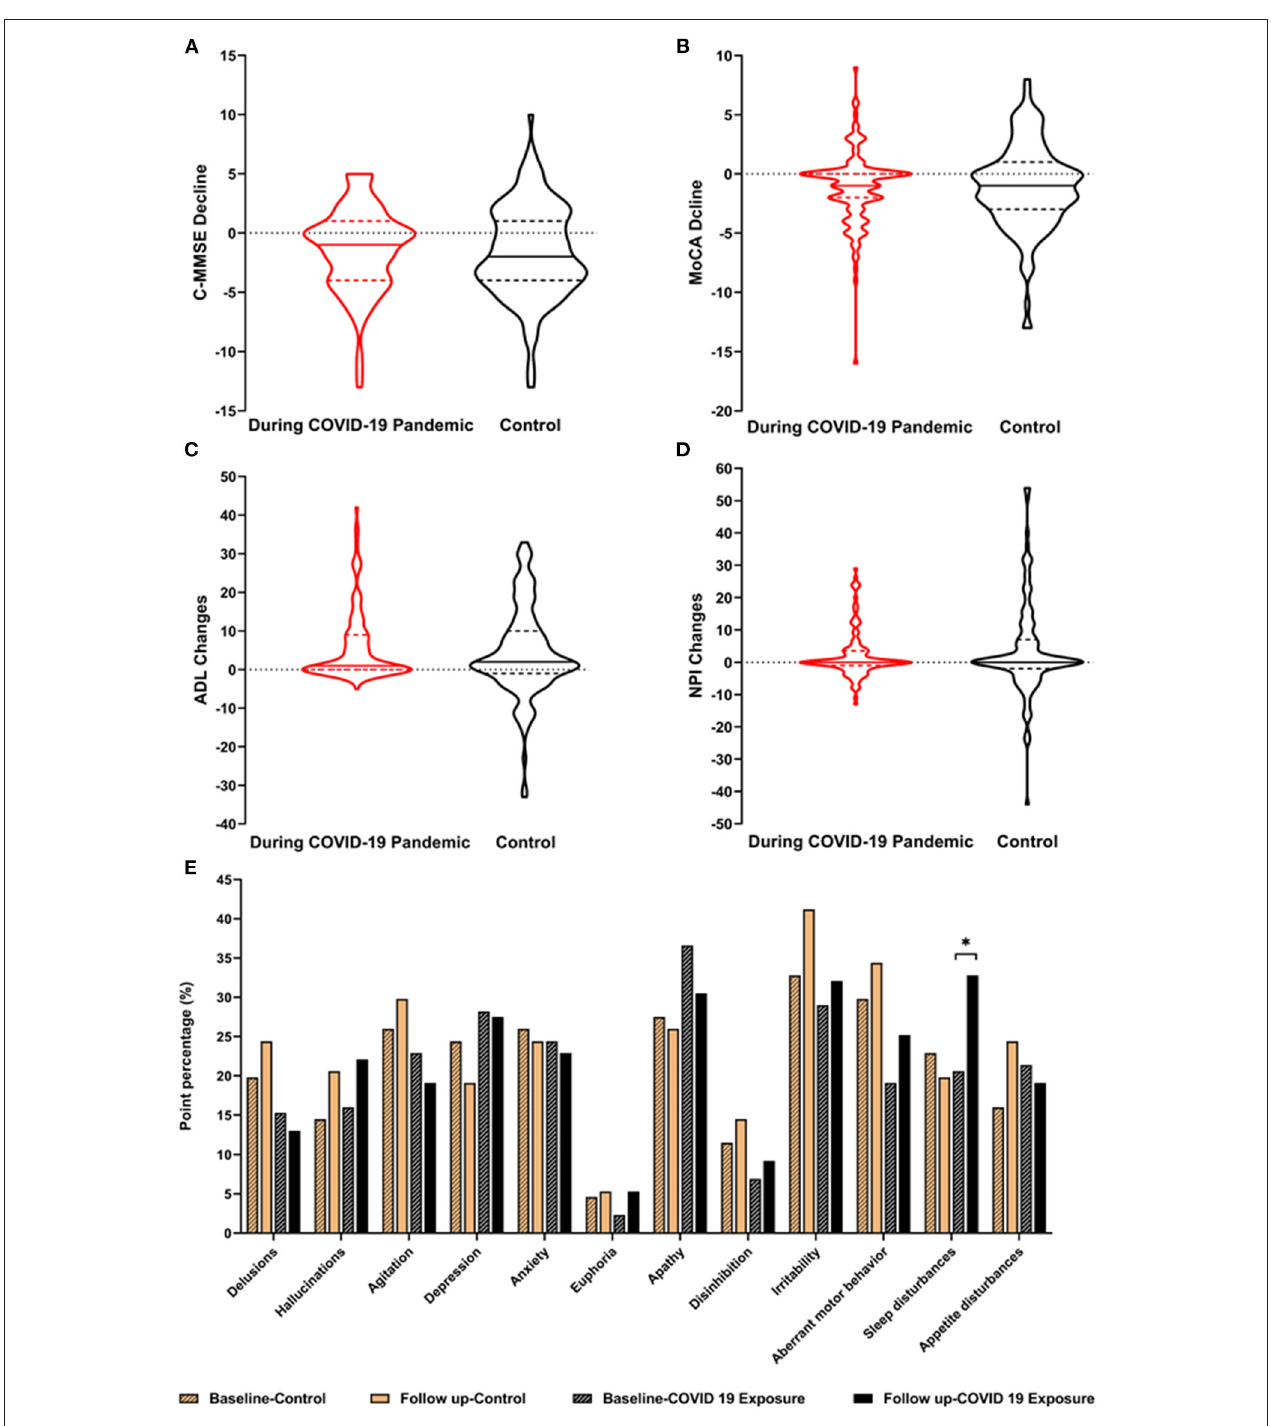
FIGURE 2 | Cognitive and neuropsychiatric changes between the AD groups. The changes in the cognitive and neuropsychiatric scores before and after the COVID-19 pandemic are described in A–E . The point percentages of the 12 NPI items are described to show the comparison before (control group) and after COVID-19 (COVID-19 exposure group) at baseline and at the 1-year follow up. AD, Alzheimer’s disease; C-MMSE, Chinese Mini-Mental State Examination; MoCA, the Montreal Cognitive Assessment; ADL, activities of daily living; NPI, the Neuropsychiatric Inventory. * p < 0.05.